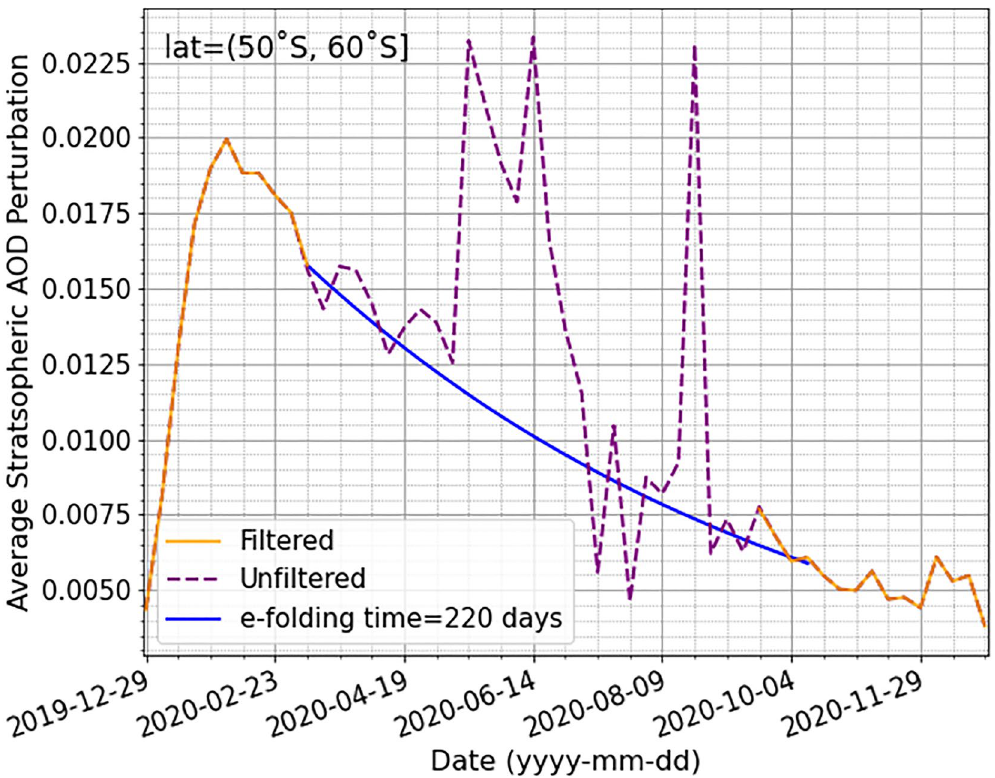
Figure 9. Weekly average perturbation in the SAOD (532 nm) following the ANY wildfires, over latitudes 50 to 60˚S, as observed by OMPS-LP including retrievals with a single scattering angle greater than 145˚ (purple dashed line) and with these retrievals removed (orange line). All retrievals are scaled from 869 to 532 nm assuming an appropriate Ångstrom exponent. The blue line shows a constant rate of decay of the SAOD, interpolating the filtered data, calculated from an e-folding time of 220